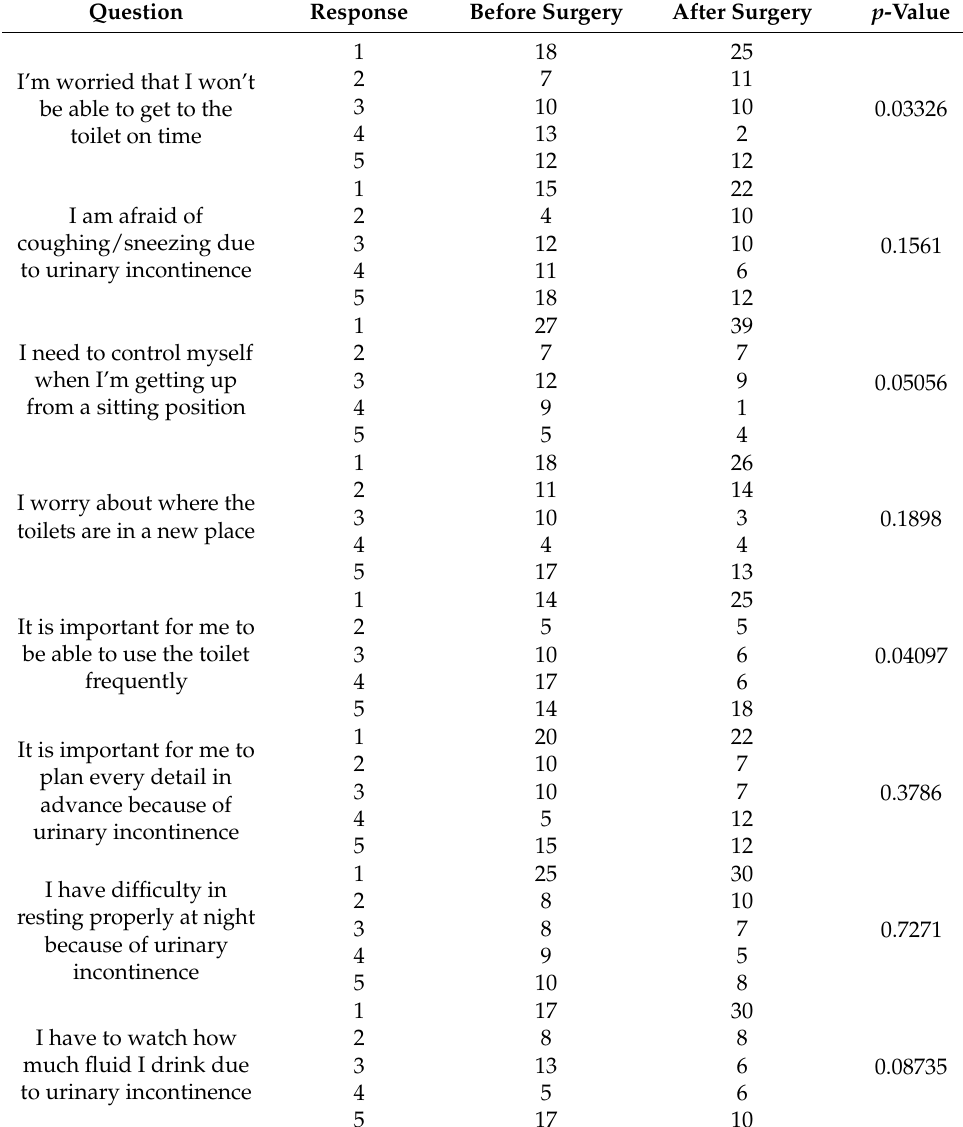
Table 4. Avoidance and limiting behavior responses from IQoL questionnaire from women before and after surgery.